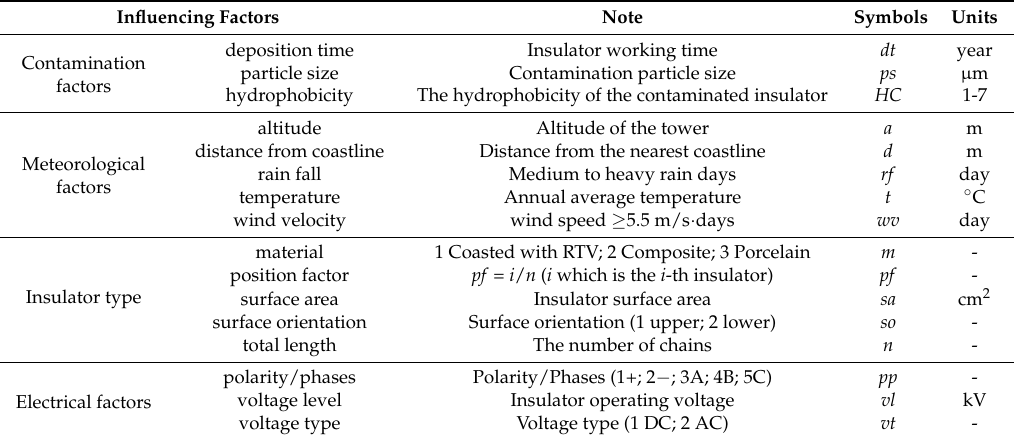
Table 2. Insulator